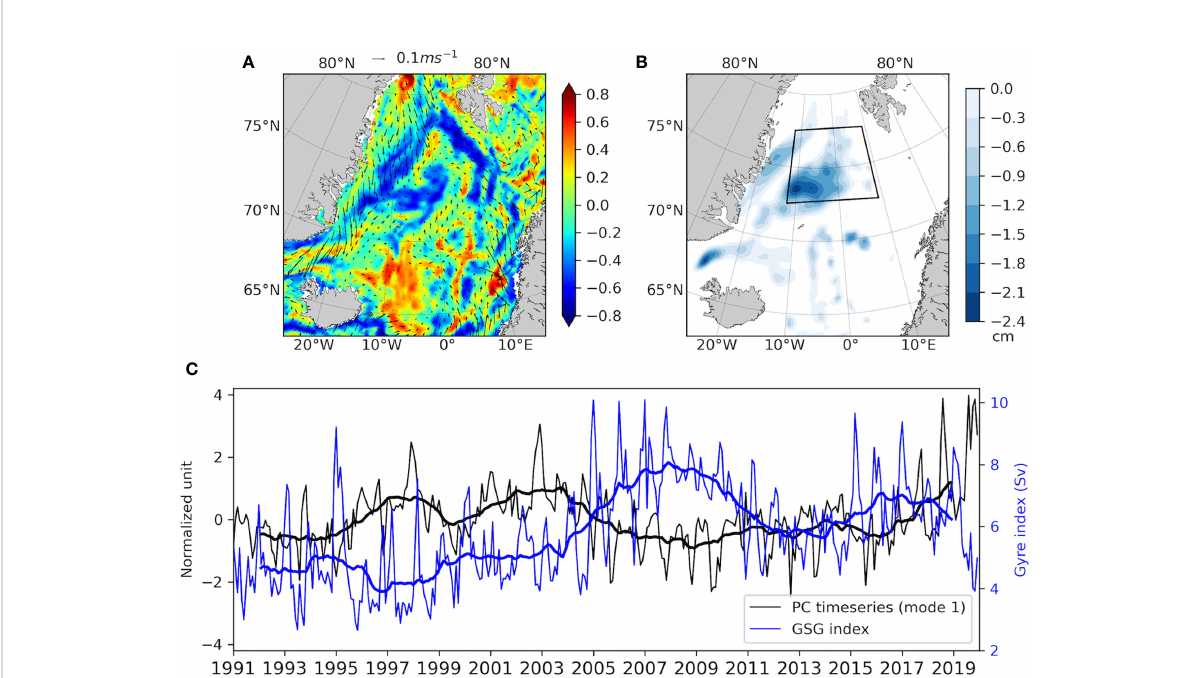
FIGURE 8 (A) Correlation map of the fi rst PC time series of salinity anomaly with surface current speed, where the vectors represent the average surface current speed over 1991-2019. (B) Composite map of sea surface height anomaly when Greenland Sea Gyre (GSG) index is above 8Sv (Sv = 10 6 m 3 s -1 ) over the region inside the box (72.5°N – 77.5°N, 12°W – 9°E). The colorbar only denotes anomalies in the negative range. (C) The fi rst PC time series of salinity anomaly and GSG index. The bolder lines represent a 25-month running average of the corresponding time